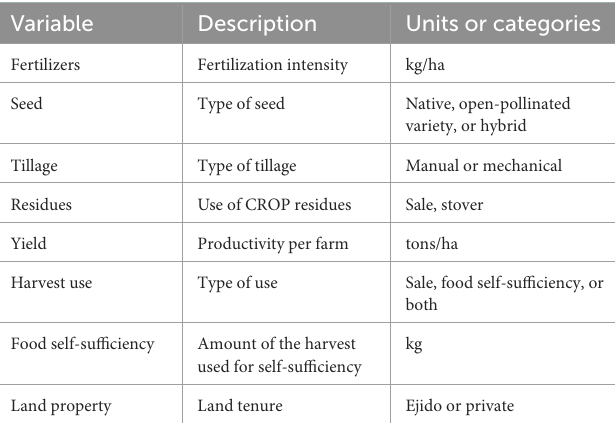
TABLE 2 Variables for farm